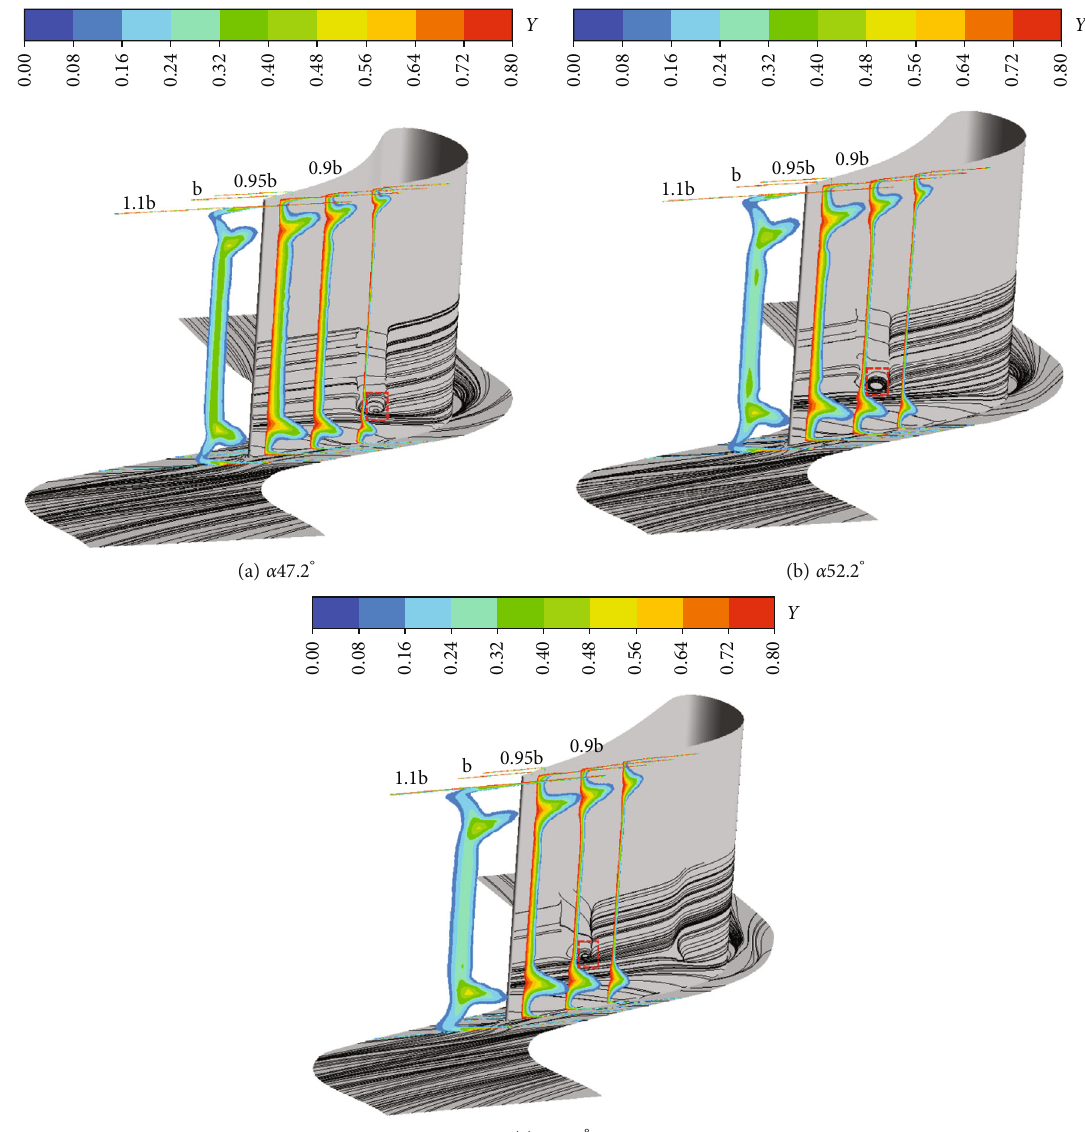
Figure 11: Comparison of total pressure loss and endwall streamline for di ff erent stagger